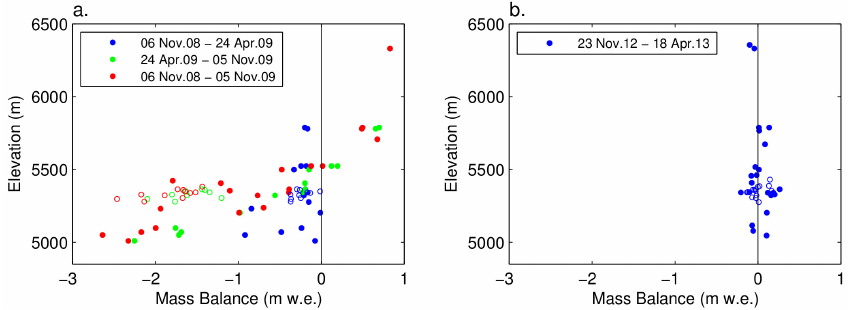
Fig. 7. (a) Point mass balance as a function of elevation, for the entire 2008–2009 year (red dots), for the winter season (blue dots) and for the summer season (green dots). Plain and open dots refer to Mera and Naulek branches, respectively. (b) Same as (a) but only for the winter season 2012–2013.